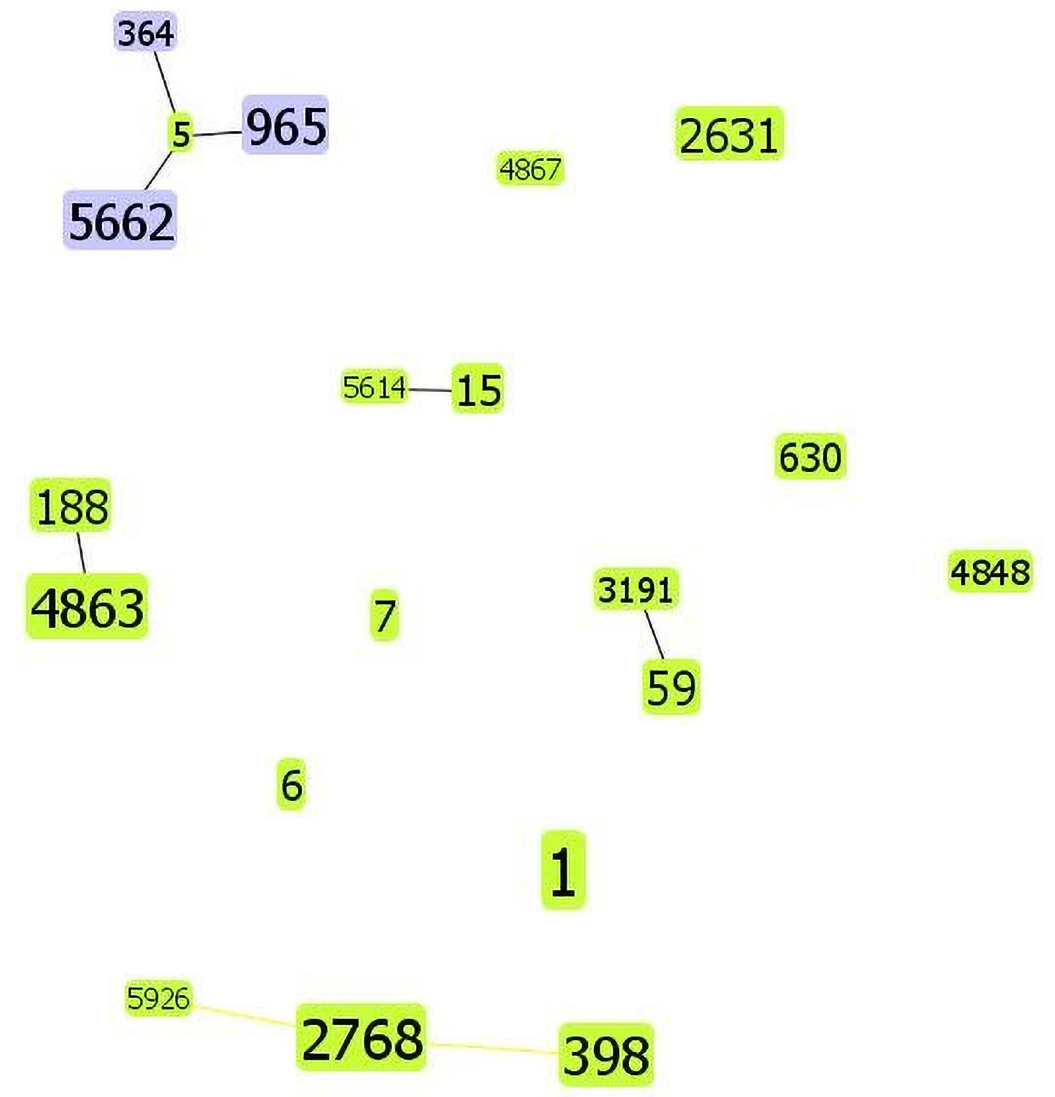
Fig 1. The diagram produced by PHYLOViZ with the stringent (default) group definition based on the MLST data of this study, representing the relationships of 122 S . aureus isolates. 0.110 ( P = 0.634), respectively. Multivariate logistic regression analysis was performed to iden- tify any significant independent risk factors. The multivariate logistic regression analysis (Table 8) showed that the significant independent risk factors for MRSA colonization were invasive devices (OR, 2.70; 95% CI, 1.09–6.68; P = 0.032), senile pruritus (OR, 2.88; 95% CI, 1.09–7.59; P = 0.033), renal insufficiency (OR, 4.12; 95% CI, 1.31–12.95; P = 0.016), and diabe- tes (OR, 2.99; 95% CI, 1.24–7.20; P = 0.015). The equation of the final model was as follows: logit P = -4.1072 + 0.9909 device + 1.0559 senile pruritus + 1.4146 renal insufficiency + 1.0950 diabetes mellitus, and the -2log likelihood was 192.189 ( P = 0.0001). The significant indepen- dent risk factors for S . aureus colonization were female sex (OR, 1.70; 95% CI, 1.04–2.79; P = 0.036) and invasive devices (OR, 2.19; 95% CI, 1.26–3.81; P = 0.006). The equation of the